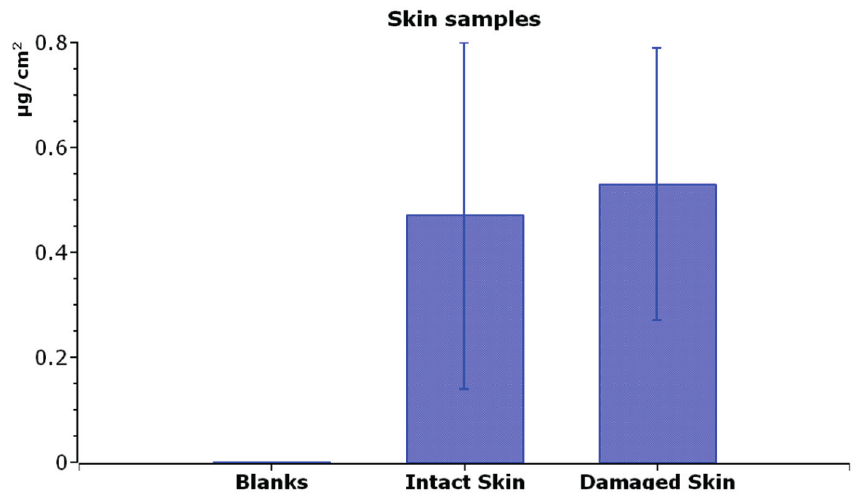
Figure 3. Titanium content (μg/cm 2 ) inside the skin (epidermis + derma) of blank cells (exposed to physiological solution), intact skin, and damaged skin (exposed to TiO 2 NPs). Mean and standard deviation of six cells